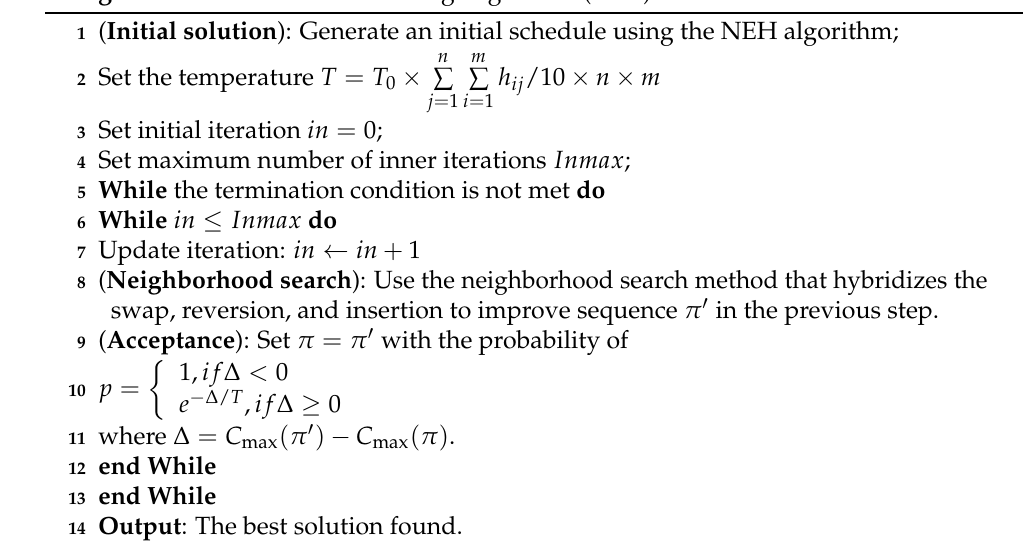
Algorithm 1: Simulated Annealing Algorithm